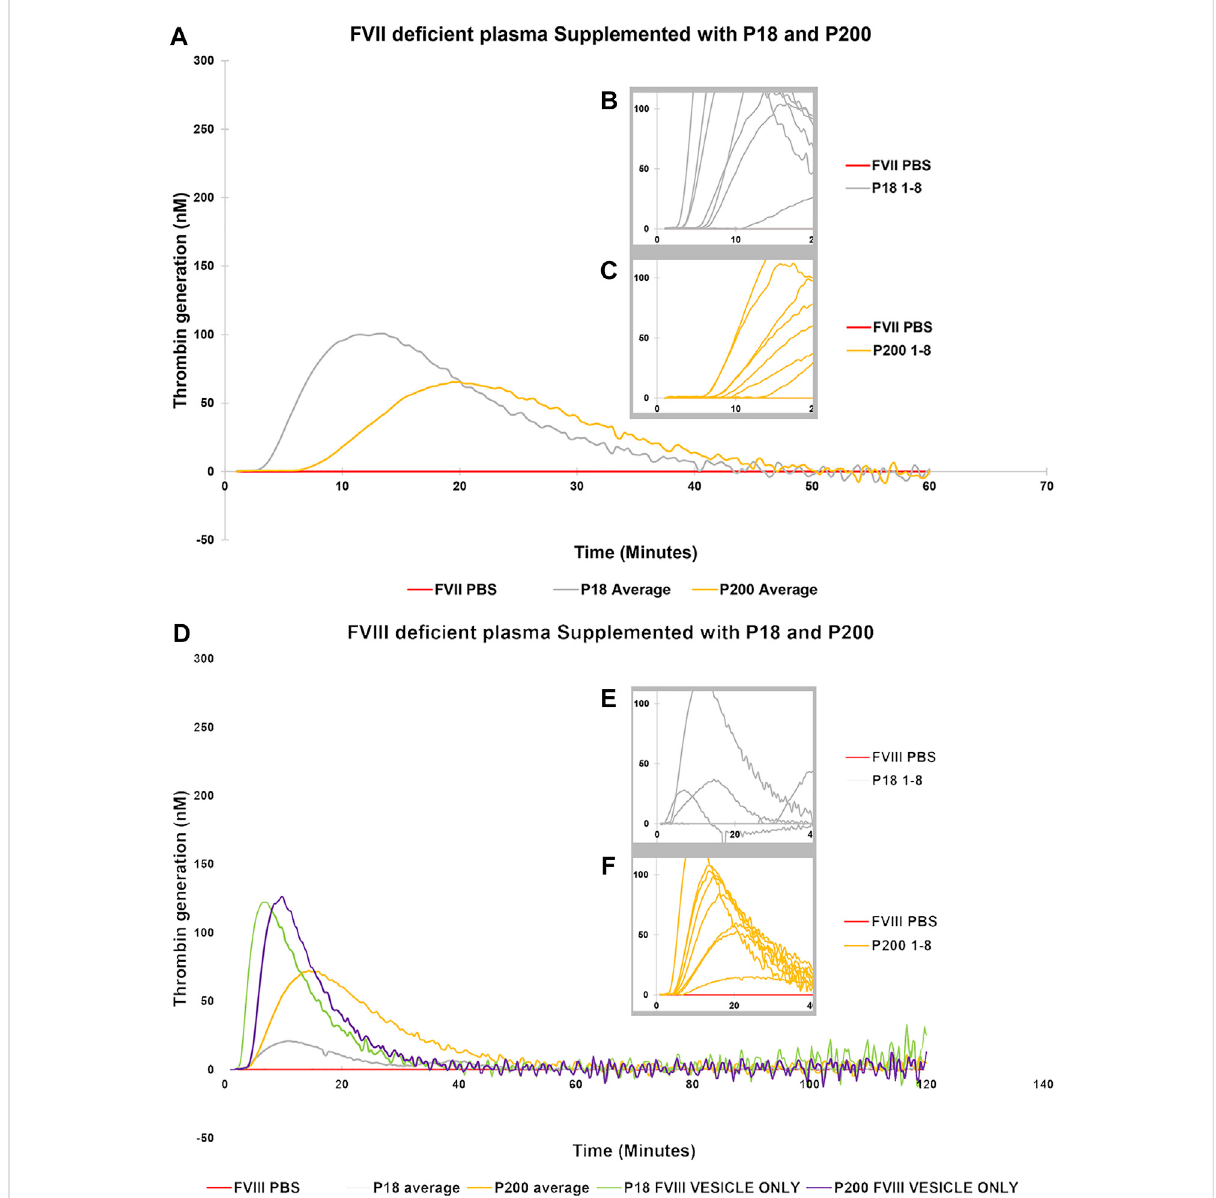
FIGURE 3 Thrombin Generation measured by Calibrated Automated Thrombogram (CAT ® ) is rescued in FVII and FVIII de fi cient plasmas by supplementation ofurinary extracellular vesicles. EVs (P18 (Grey line, microvesicles) and P200(Orange line,exosomes)weresupplemented into FVII de fi cient plasma (A – C) , and TG was measured after challenging theplasma with the PRP reagent (1pM TF withoutPLs). Similarly, P18 and P200 were supplementedintoFVIIIde fi cientplasmas (D – F) ,andTGwasmeasuredafterchallengingtheplasmawithPRPreagent.Dilutedplasma(withPBS at same volume as EVs) was used a control (Red line). In A and B the averages at every time point for 8 measurements for both P18 and 8 P200 are shown.These8separatemeasurementsareEVs(P18andP200)puri fi edfrom8individuals.Theaverageisdepictedtoenhanceclarity.Insetdiagrams (B and C for FVII and E and F for FVIII) show a cut portion of the original diagram with 8 individuals ’ measurements to highlight the differences in lag time (start of the TG) between the individuals (not evident in A and D). X-axis represents time and Y-axis TG in nM. Individual curves and statistics are described in Supplementary Figures S10,